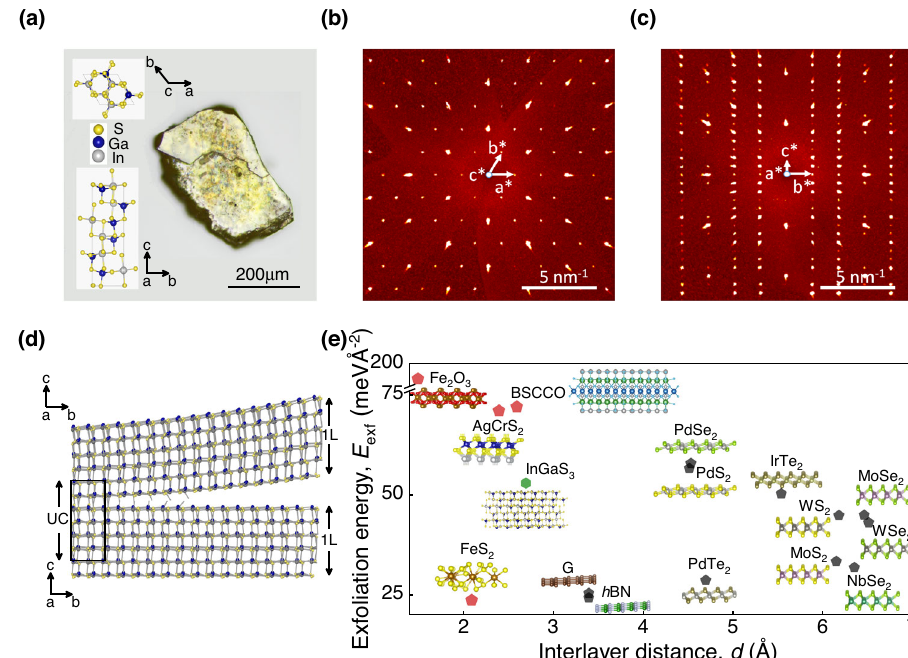
Fig. 1 Crystal structure and interlayer binding energies of non-van der Waals InGaS 3 . a 5X optical micrograph of bulk crystal on a glass slide. Inset: Top and side views of P6 5 space group hexagonal crystal structure with lattice constants of a = b = 6.6 Å , c = 17.9 Å. a , b , c and a* , b* , c* label real and reciprocal space crystallographic axes, correspondingly. b X-ray diffraction micrograph of the crystal presented in panel ( a ) across a*b* -plane. c Same as ( b ), but across c*b *-plane. d Schematic illustration of layer separation achieved by cutting off the weak non-van der Waals bonds. UC, 1 L stand for unit cell and cleaved monolayer, respectively. e Typical exfoliation energies of conventional van der Waals (black pentagons) and non-van der Waals (red pentagons) materials evaluated via fi rst principles calculations. Green hexagon presents our estimation of the exfoliation energy along the proposed minimal energy atomic